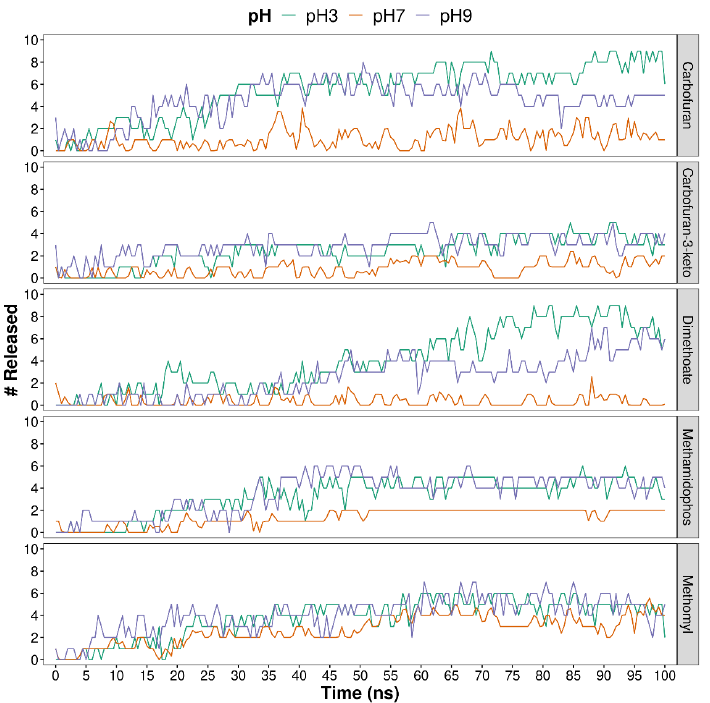
Figure 2. Number of compounds released from ALG-CT hydrogels, during the 100 ns of molecular dynamics simulations. A total of 3 pH values were considered. The release of pesticides was calculated during the simulation by counting, in each step, the pesticide molecules located more than 5 Å away from the hydrogel.